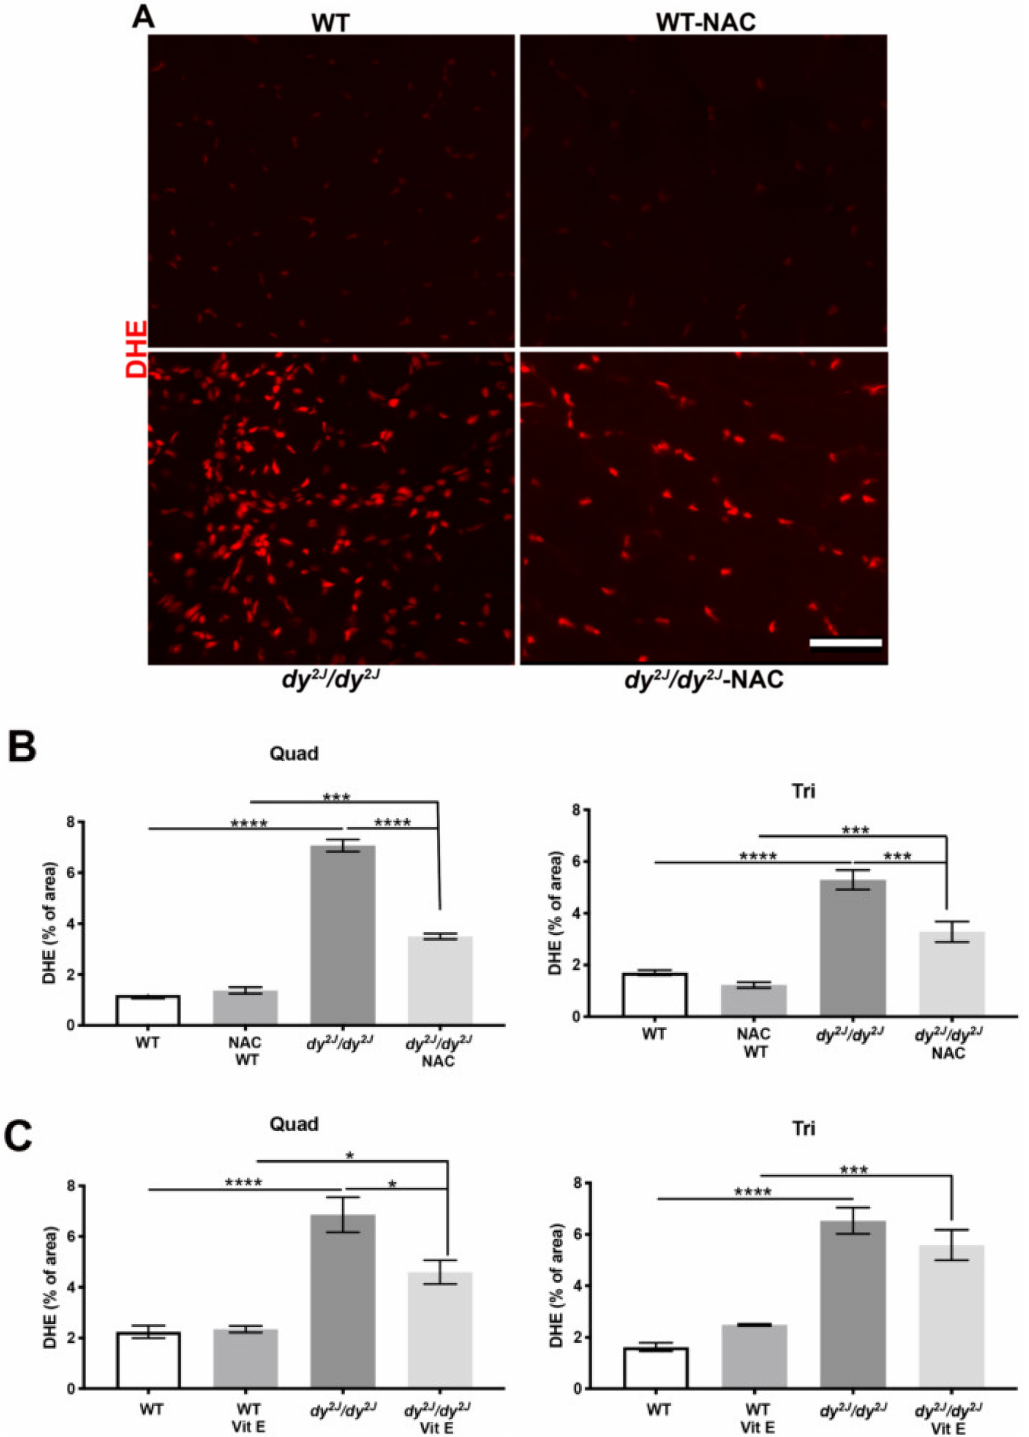
Figure 6. ( A ) Representative DHE-stained quadriceps muscle sections; ( B ) Quantification of DHE-positive areas in 6 WT, 6 WT NAC, 5 dy 2J / dy 2J , 6 dy 2J / dy 2J NAC quadriceps and triceps muscles; ( C ) DHE-positive areas in 6 WT, 5 WT vit E, 5 dy 2J / dy 2J , 5 dy 2J / dy 2J vit E quadriceps and triceps muscles. * p < 0.05, *** p < 0.001 and**** p < 0.0001. Bar: 50 µ